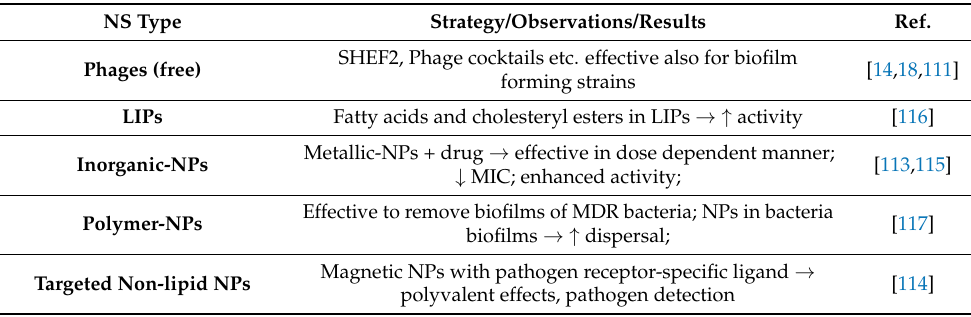
Table 3. Nanosystems for the treatment of VRE